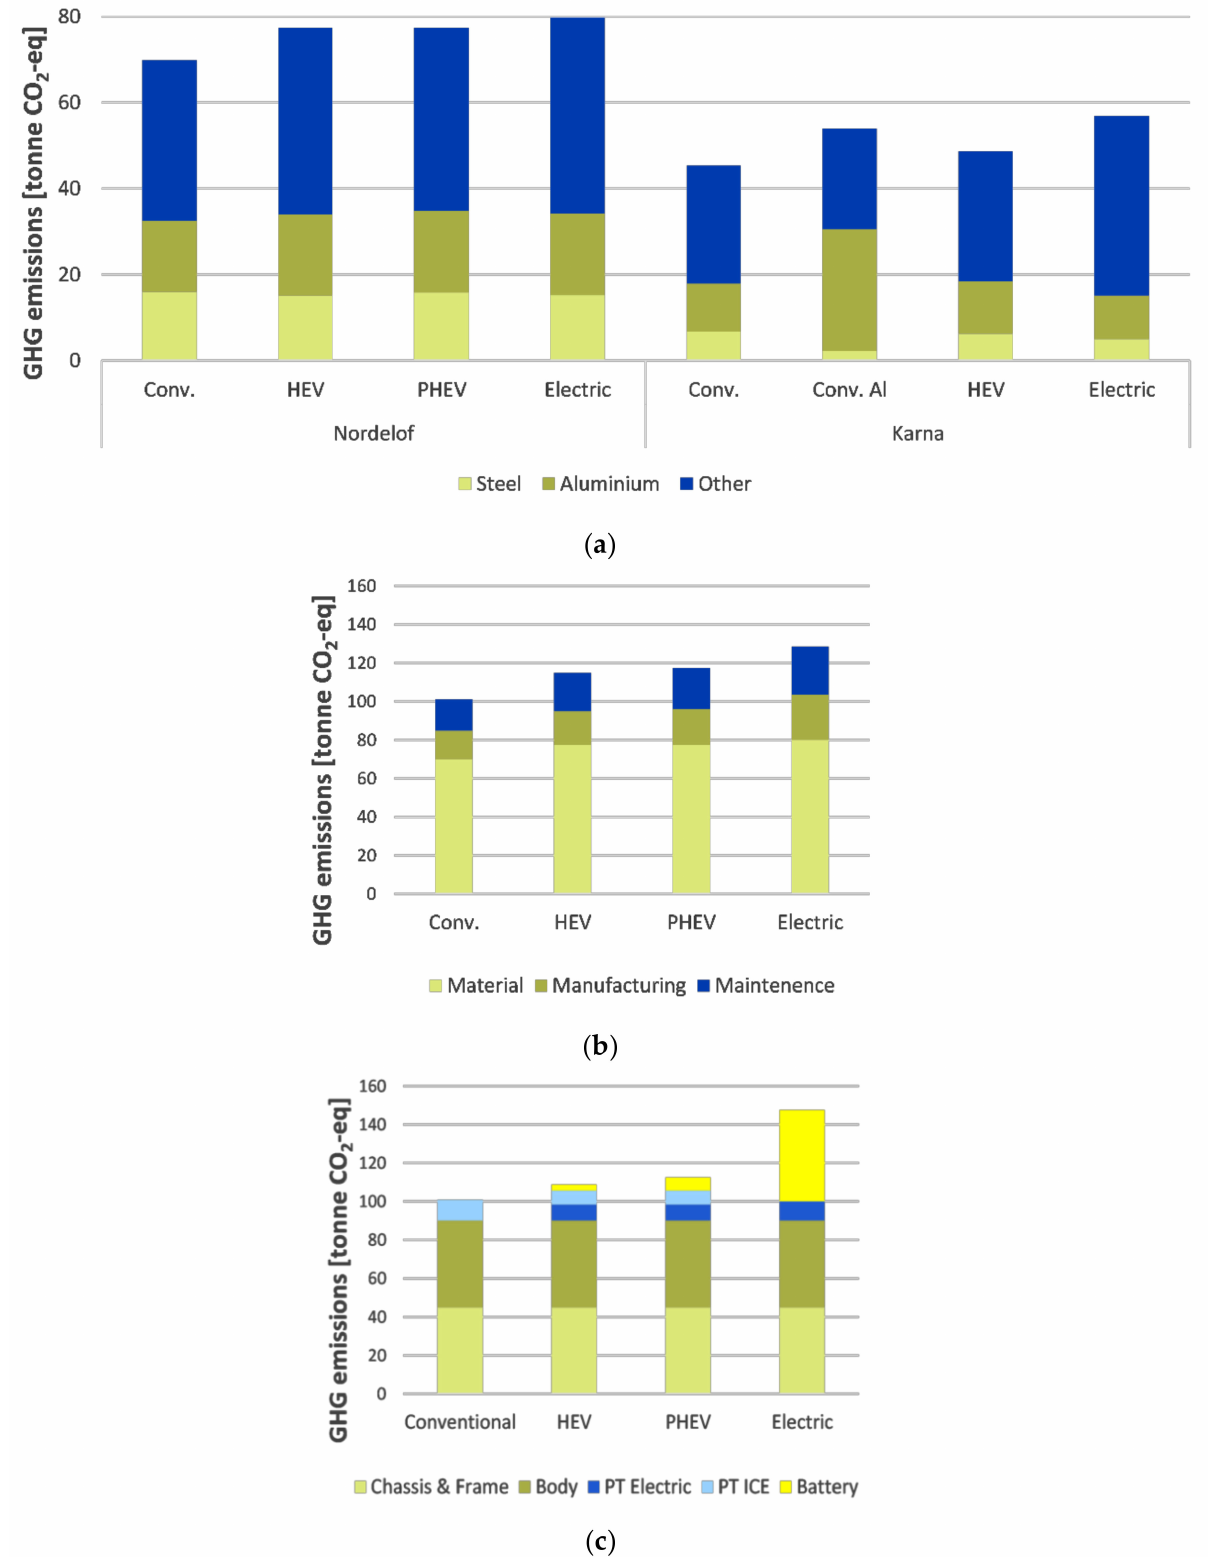
Figure 3. ( a ), upstream material production emissions from electric, diesel, PHEV and HEV bus from two LCA studies [50,65]; ( b ), embodied GHG emissions from the first-generation Volvo bus models presented with material, manufacturing and maintenance emissions [50]; and, ( c ), Estimated component GHG emissions from four Volvo bus models [50,60]. Conv, conventional; Al, aluminium; PT, powertrain; ICE, internal combustion